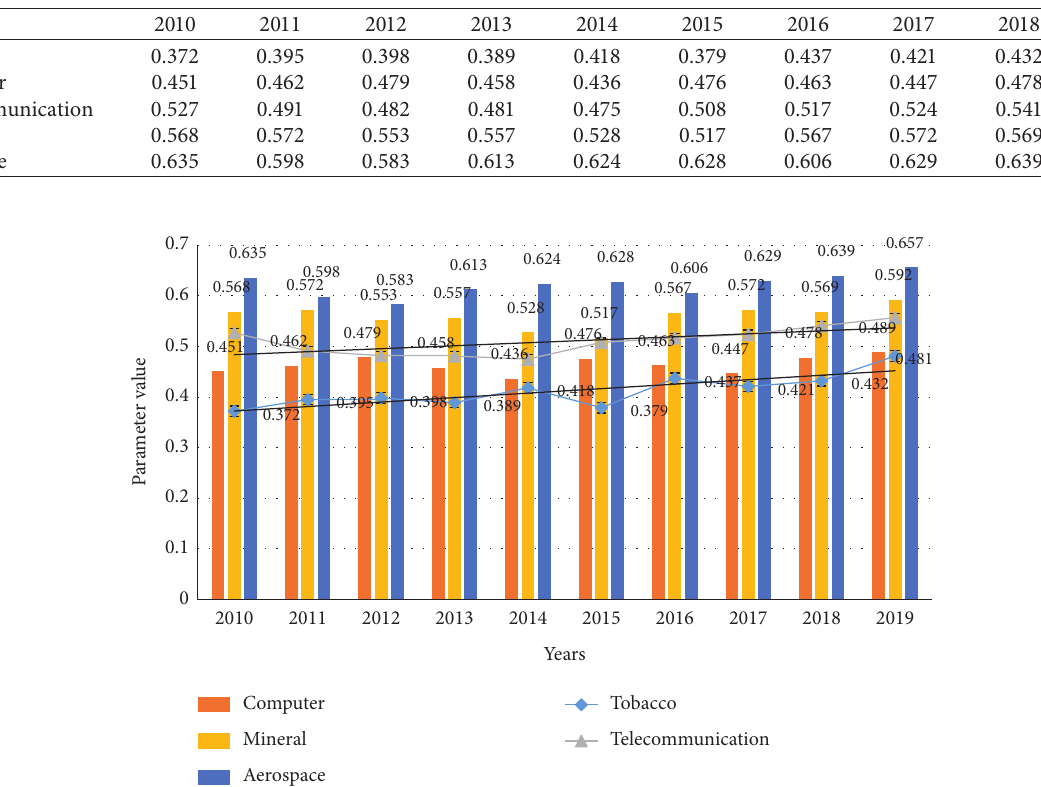
Figure 6: Green innovation value